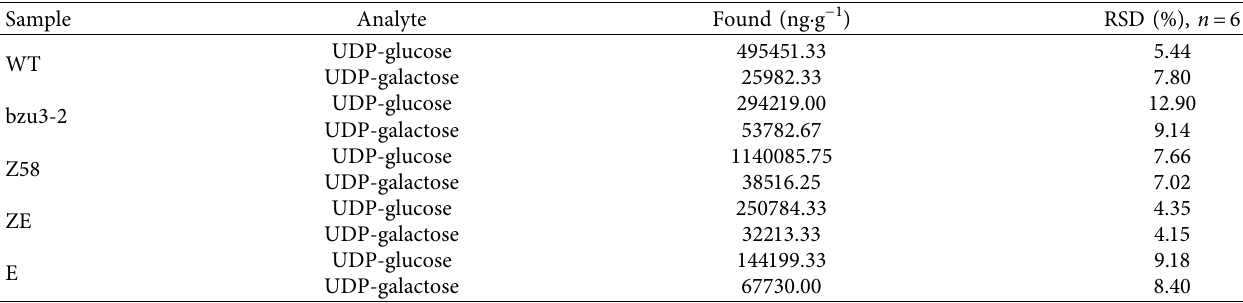
Table 4: Results of UDP-galactose and UDP-glucose in different maize samples.